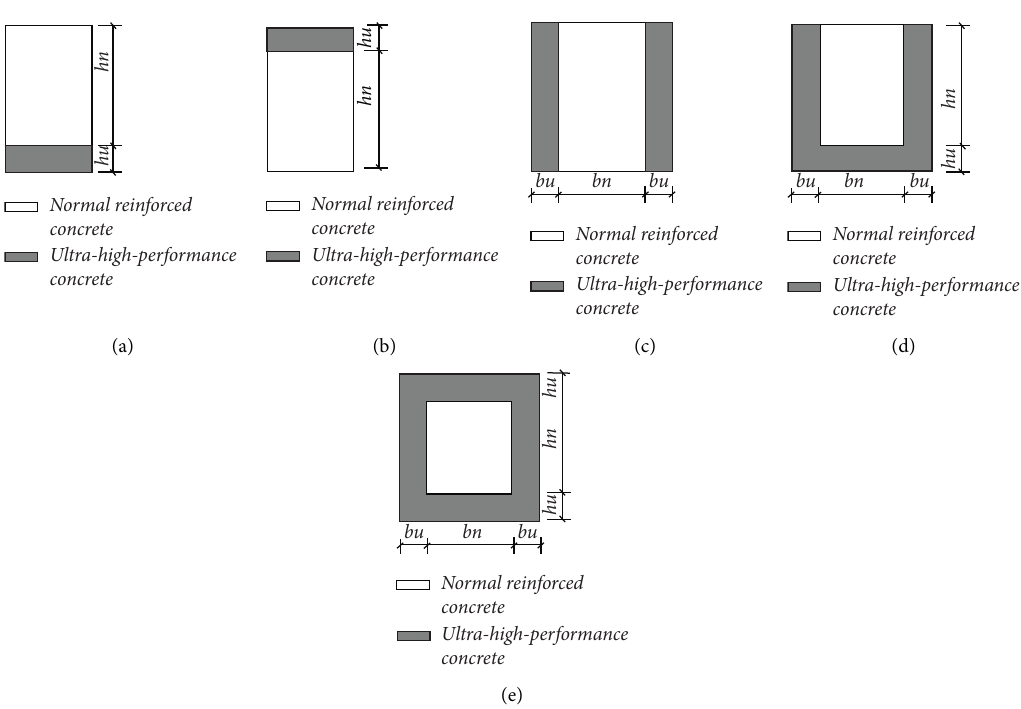
Figure 6: Section details